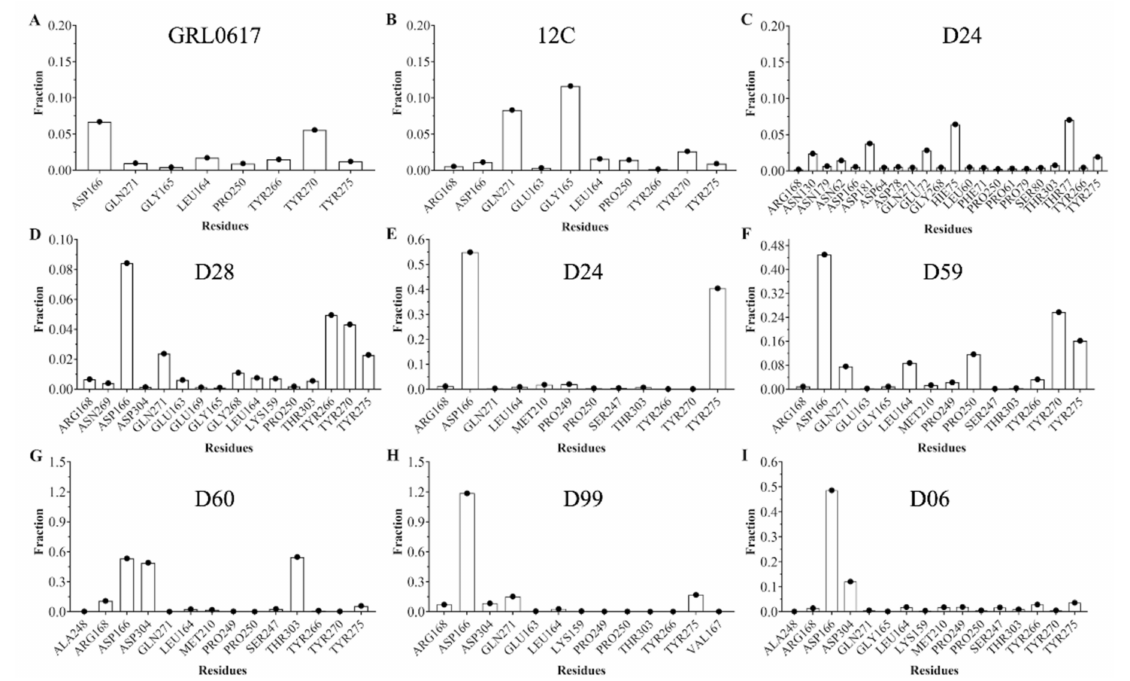
Figure 5. Fraction of intermolecular hydrogen bonds for SARS-CoV-2 PLpro interacting with controls ( A , B ) and selected ligands ( C – I ). The bar graph shows the most common hydrogen bonds formed between the pocket residues and the studied molecules. Values obtained from the CPPTRAJ script in